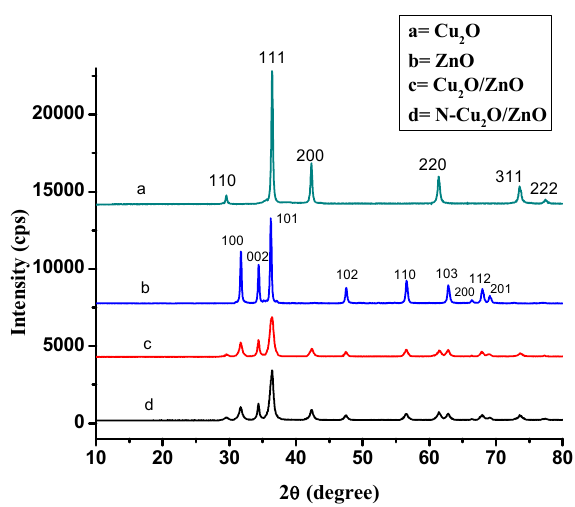
Figure 1. X-ray di ff ractogram of (a) Cu 2 O, (b) ZnO, (c) Cu 2 O / ZnO and (d) N-doped Figure 1. X-ray diffractogram of (a) Cu 2 O, (b) ZnO, (c) Cu 2 O/ZnO and (d) N-doped Cu 2 O/ZnO Cu 2 O / ZnO nanomaterials.